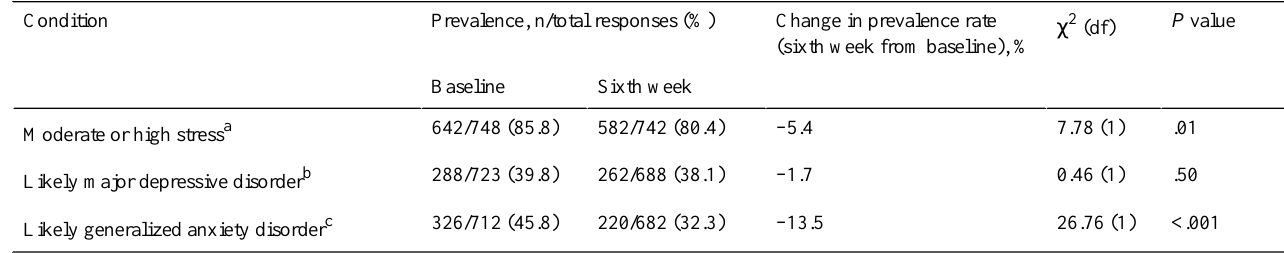
Table 3. Comparison of the baseline and 6-week prevalence of moderate or high stress, likely generalized anxiety disorder, and likely major depressive